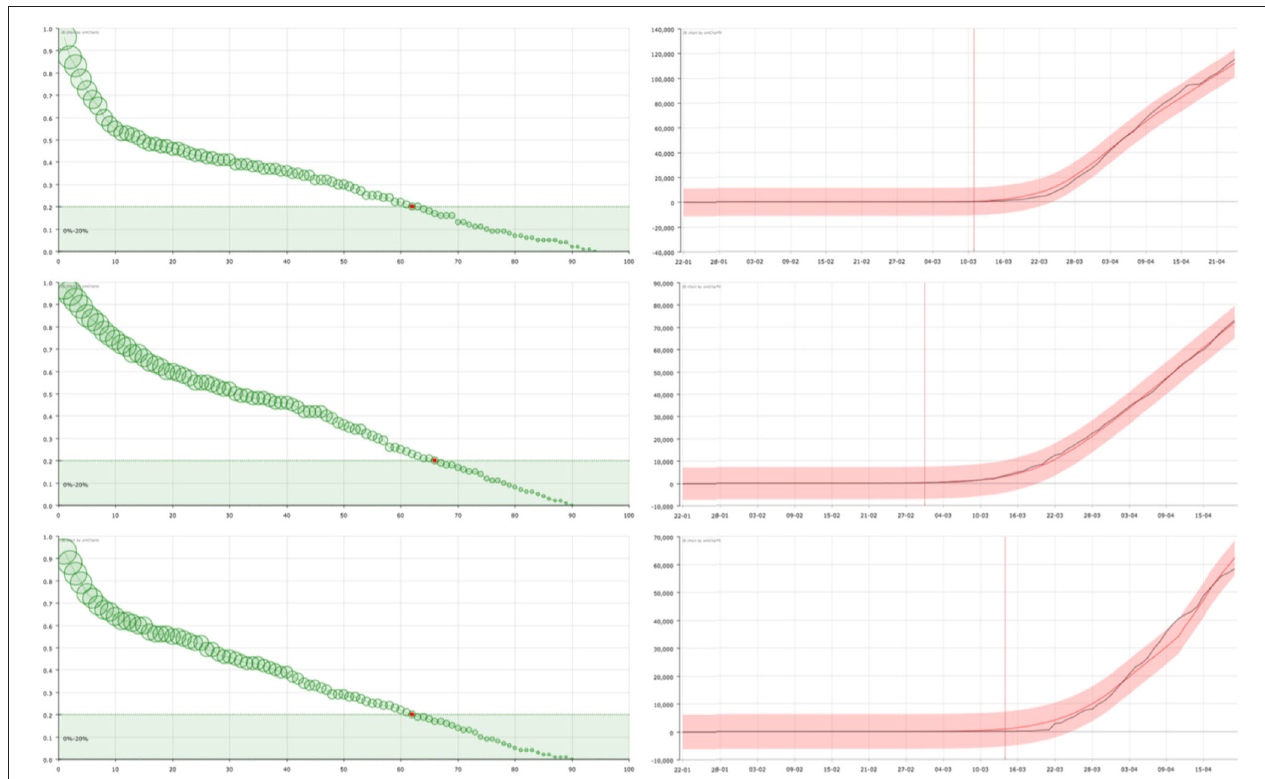
FIGURE 4 | On the right, curve fitting of the sum of the accumulated number of recovered and dead people in Spain (top) , Italy (center) , and France (bottom) : black X ). The x-axis represent the date and the y-axis represents the number of cases. Vertical line signs the 100 line is the real value ( X ) and red line is the approximation ( b cases. On the left, the corresponding survival curve of the virus S . The red point signs the number of days after which a standard individual has a probability of staying in the group of infected people smaller than 0.2. This value has been arbitrarily set as an aid to the visualization of the decreasing of the curve. The size of the balls is proportional to their value at the